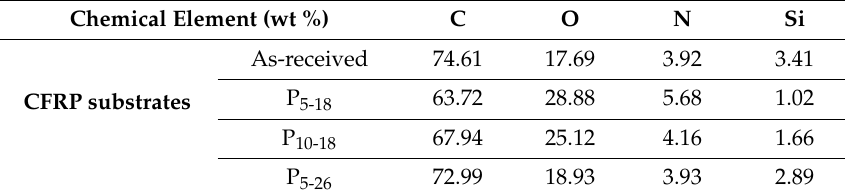
Table 6. The chemical compositions of CFRP substrate surfaces.